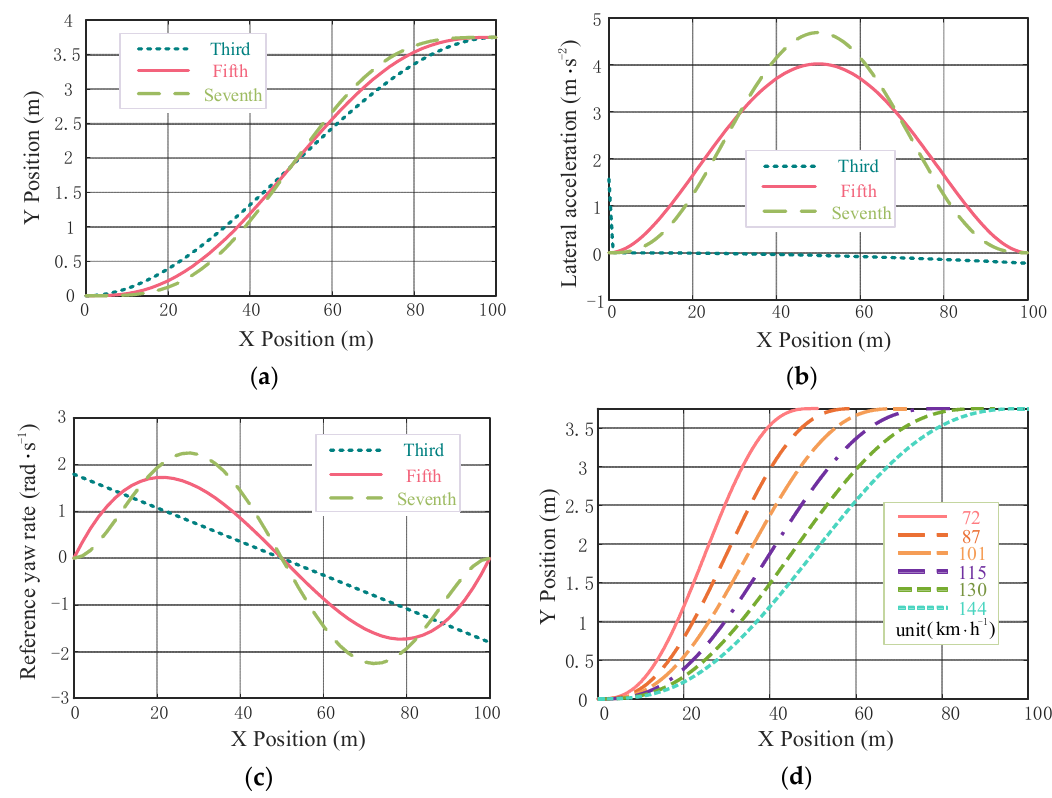
Figure 2. ( a ) Comparison of different polynomial reference paths; ( b ) Comparison of lateral acceleration. ( c ) Comparison of reference yaw rate; ( d ) Lateral reference displacement of fifth order at different speeds.